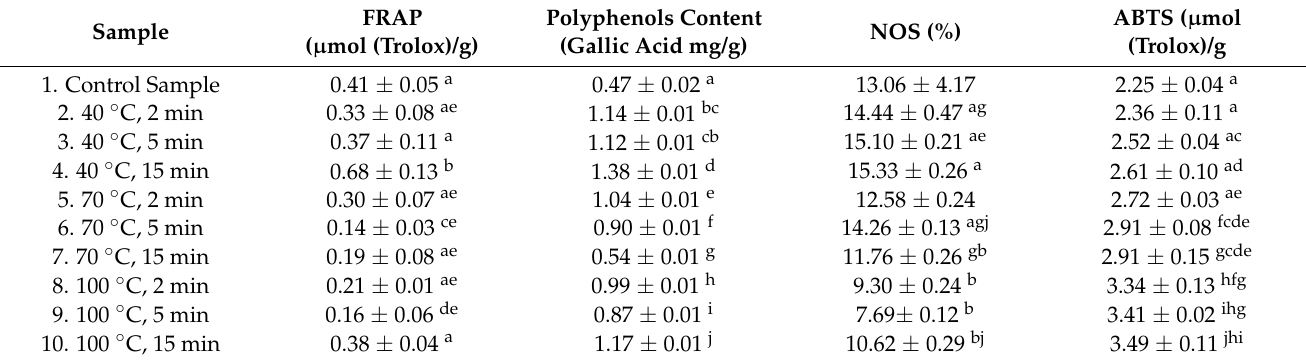
Table 3. Effect of sample heat treatment at 40, 70, 100 ◦ C on the value of antioxidant activity in watermelon determined by FRAP, NOS, ABTS methods, and total polyphenols